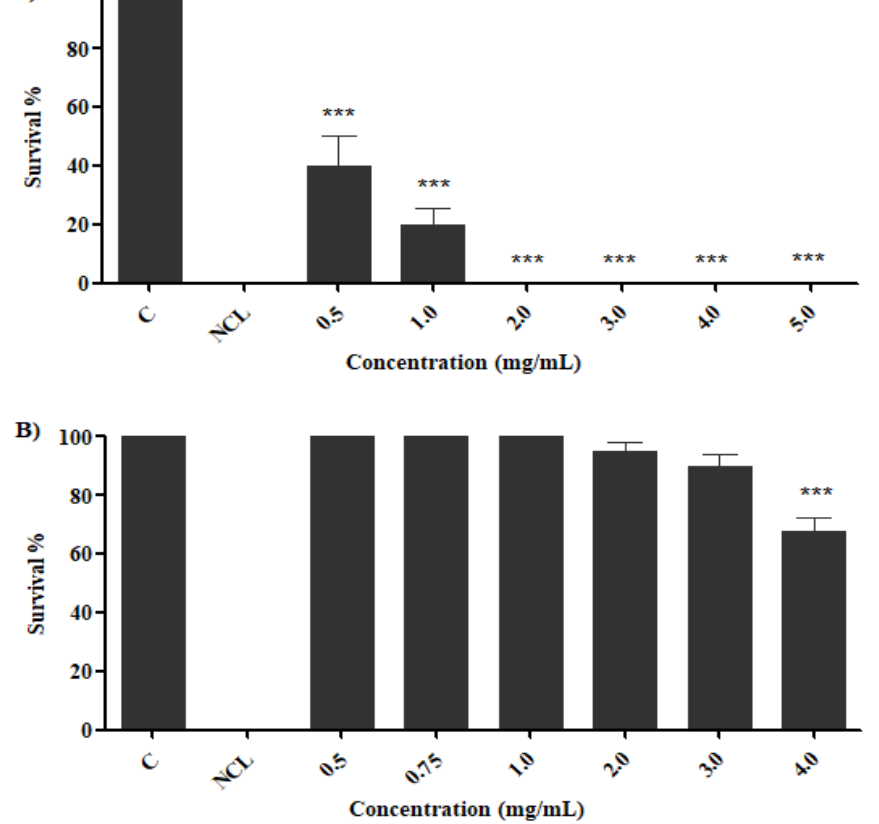
Figure 8. Survival of A. salina to B. monandra preparations after 24h exposure. Exposed to saline extract ( A ) and fraction ( B ). C: negative control; NCL: niclosamide: 1.0 µg/mL. Each concentration was compared with negative control: significance *** = p < 0.001.